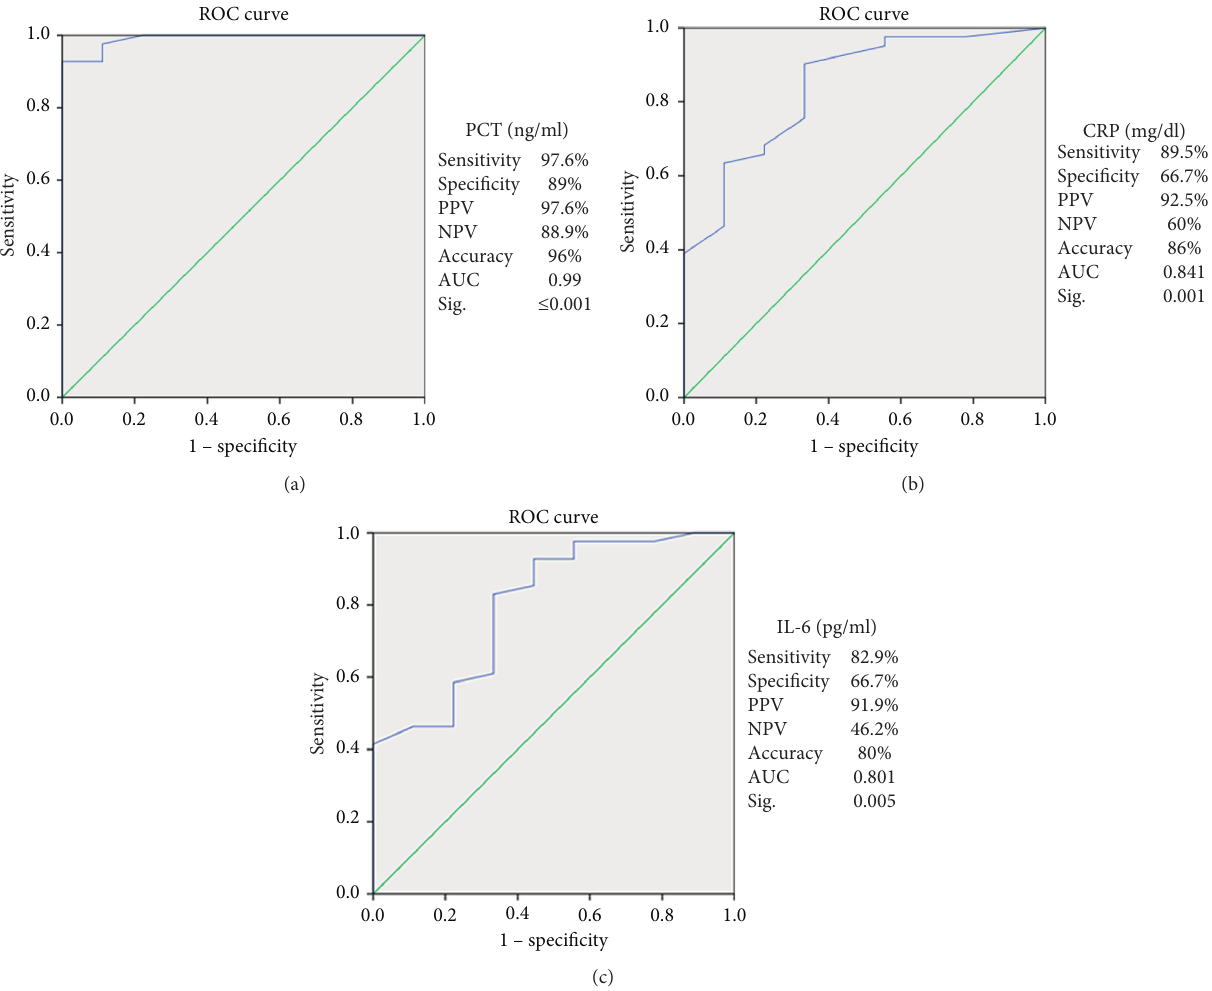
Figure 2: Receiver operating characteristics (ROC) curves for the studied sepsis markers: (a) ROC curve for PCT: AUC: 0.991, p value ≤ 0.001. (b) ROC curve for CRP: AUC: 0.841, p value � 0.001 (c) ROC curve for IL-6: AUC: 0.801, p value � 0.005. PCT: procalcitonin, CRP: C-reactive protein, IL-6: interleukin 6, PPV: positive predictive value, NPV: negative predictive value, and AUC: area under the curve. Diagonal segments are produced by